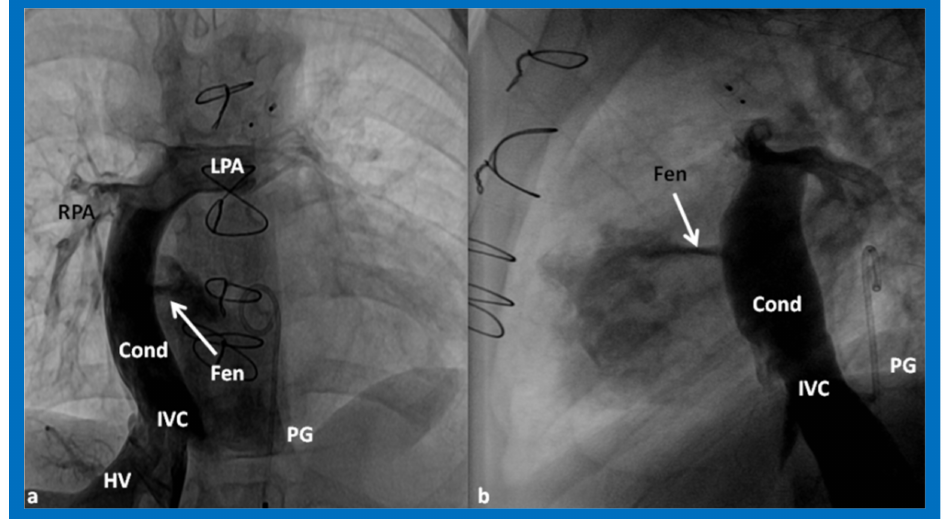
Figure 17. Cine-angiographic images in postero-anterior ( a ) and lateral ( b ) views, illustrating Stage IIIA of the Fontan operation rerouting the blood flow from the inferior vena cava (IVC) into the right (RPA) and left (LPA) pulmonary arteries through a non-valved Gore-Tex conduit (Cond). The flow of the contrast material via the fenestration (Fen) is indicated by the arrows in both a and b . HV, hepatic veins; PG, pigtail catheter. Modified from Reference [12].